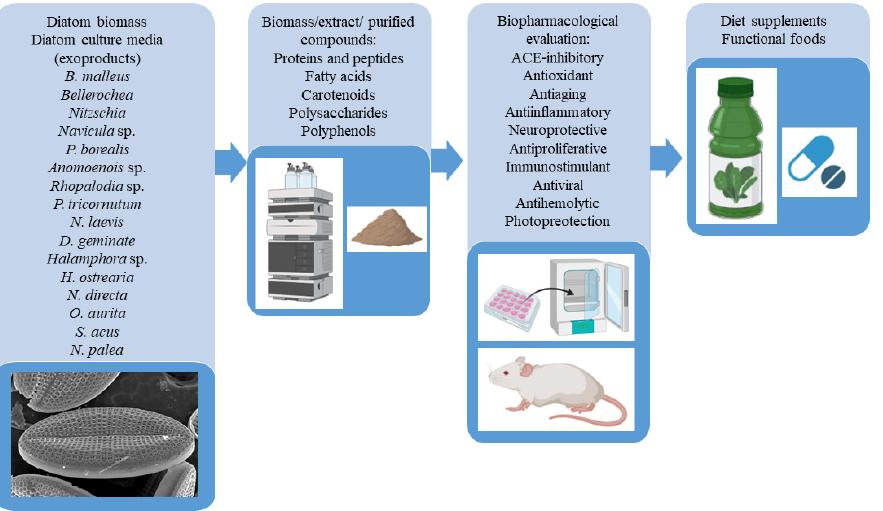
Figure 3. Pipeline adopted to obtain potential use of diatoms as biomass, extracts or purified compounds in functional food and diet supplements.